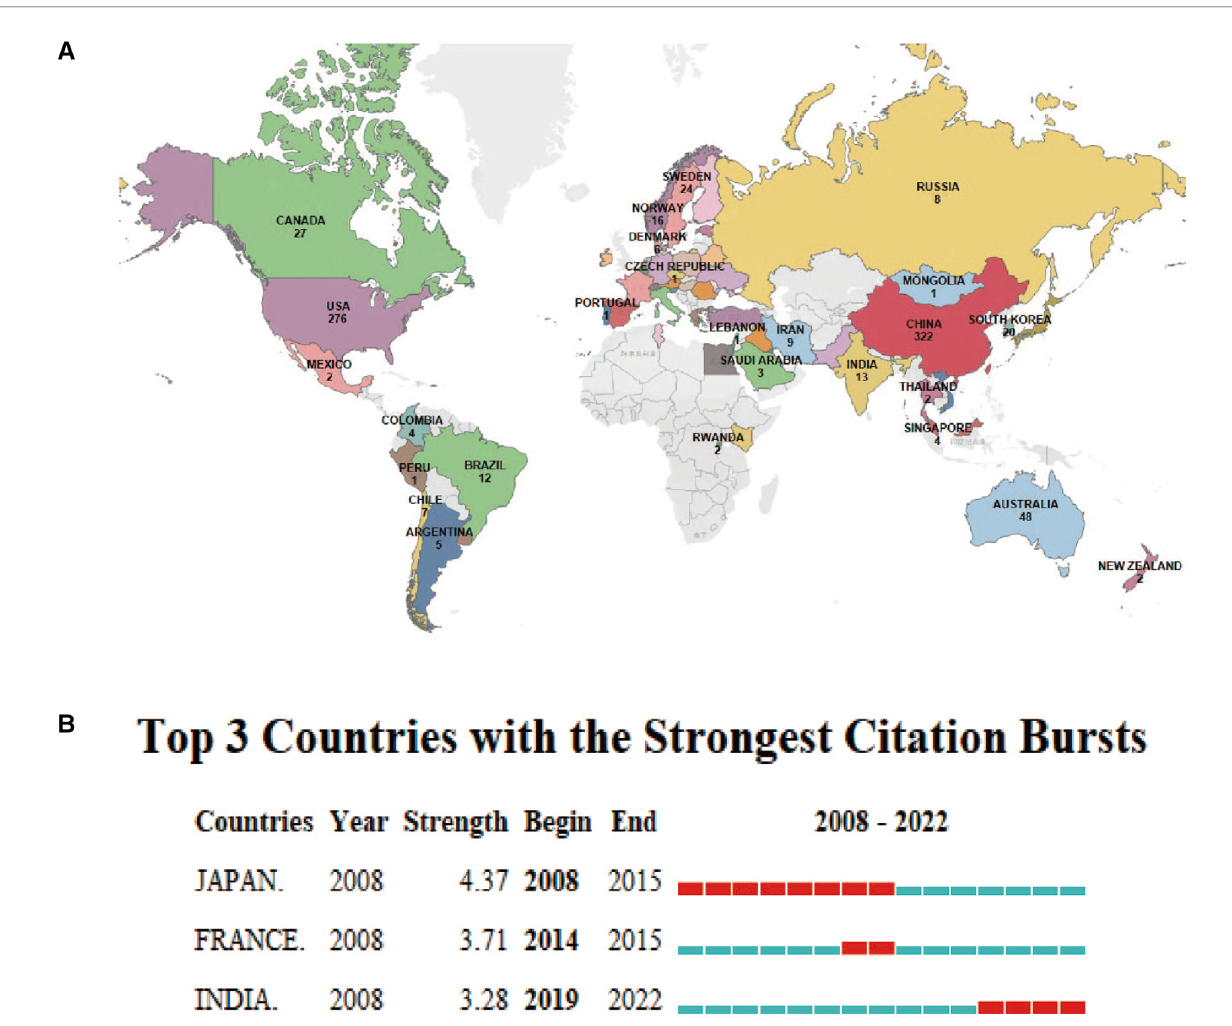
FIGURE 3 Distribution of global publications in the fi eld of in fl ammasomes in atherosclerosis. ( A ) The documents of “ in fl ammasome AND atherosclerosis ” . The colors indicate the number of documents in each country, while gray represents countries with no publications. ( B ) Top 3 countries/regions with the